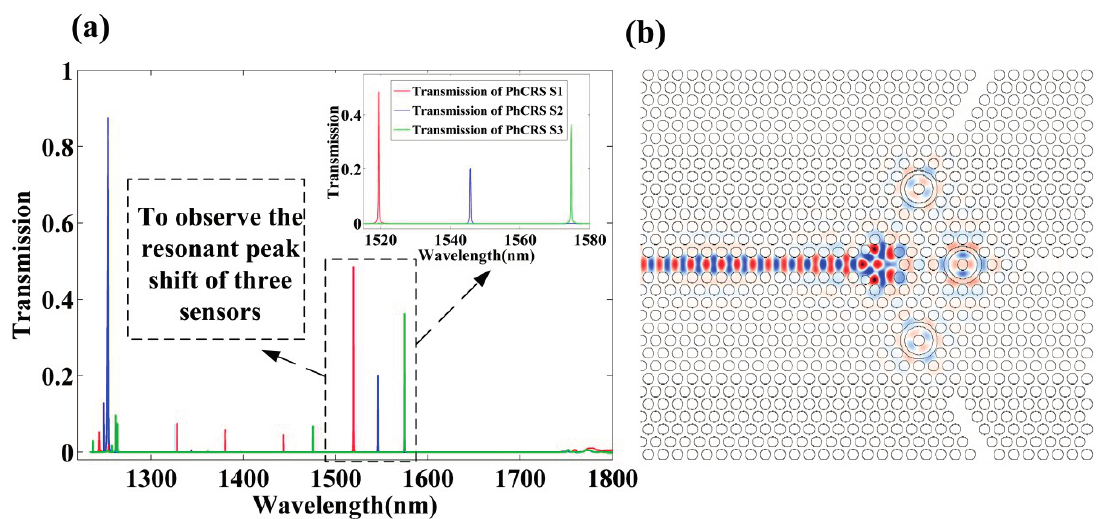
Figure 2. ( a ) The transmission spectra of three ring-slot cavities (PhCRSS1, PhCRSS2, PhCRSS3) in water environment (RI = 1.330), and observing the resonant peaks of three ring-slot cavities surrounded by black dashed line shift when the RI of functionalized area is changed; ( b ) The steady-state electric field profile through three ring-slot